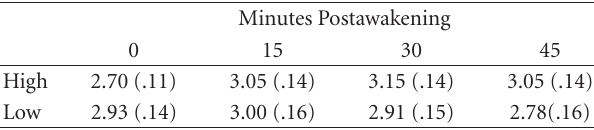
Table 3: Means (SEM) of salivary cortisol concentrations (sqrtnmol/L) in older people with high versus low scores in social network cultivation in the postawakening period.